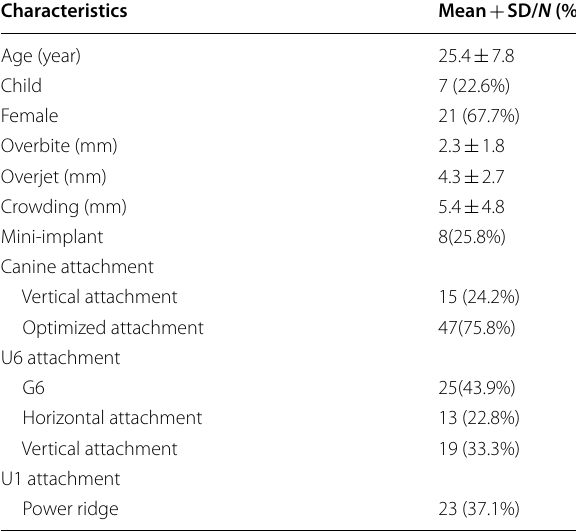
Table 1 Baseline patient